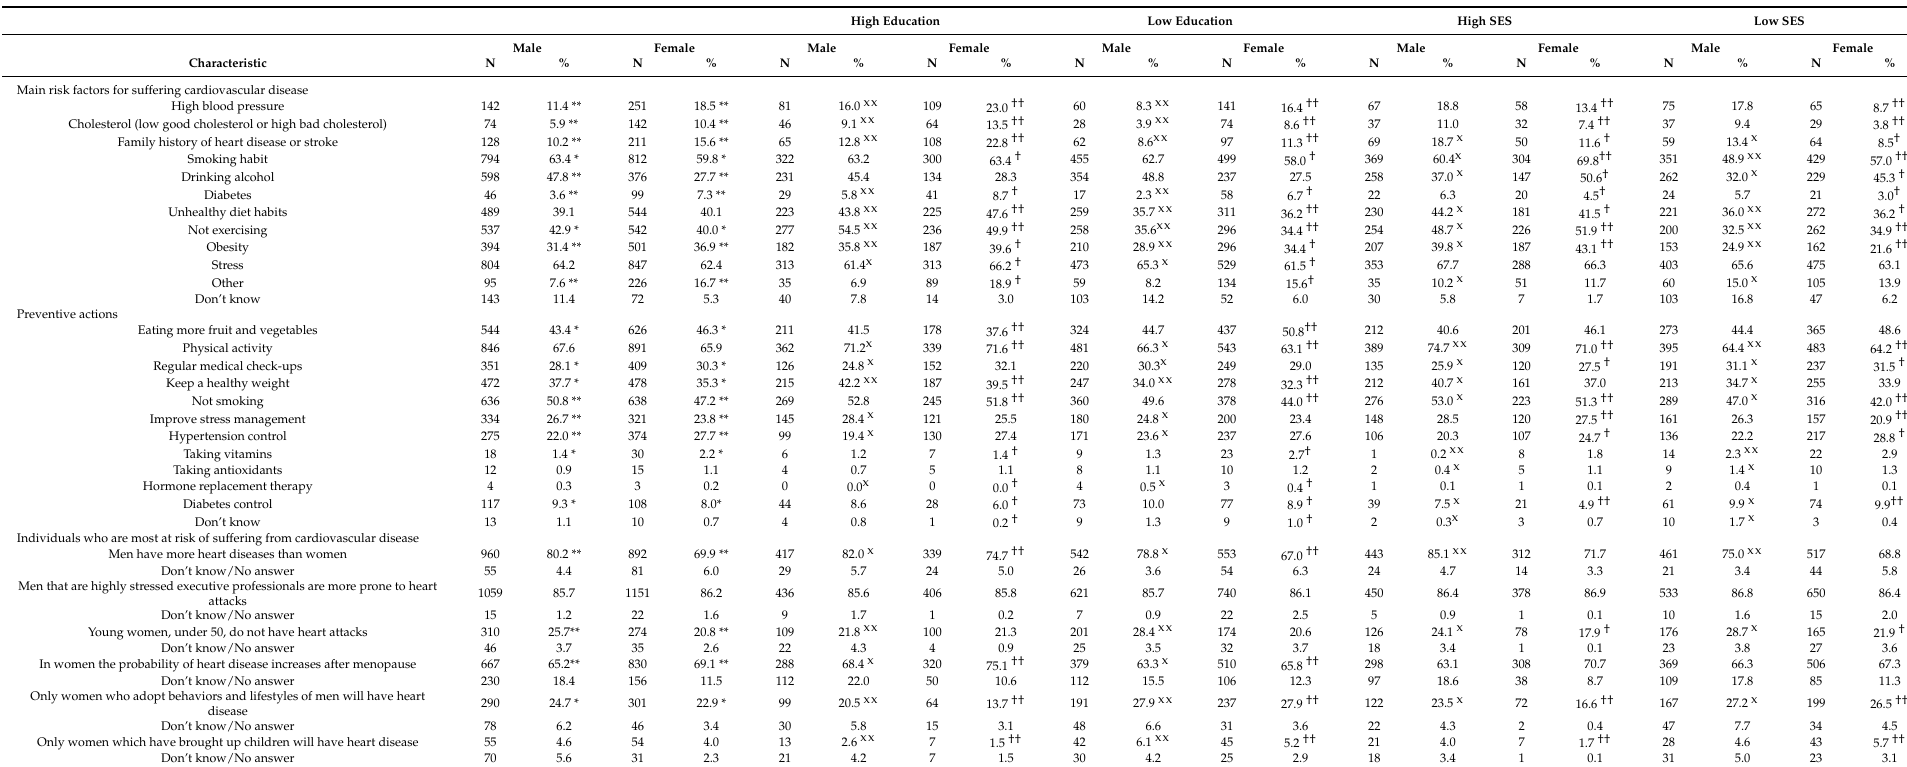
Table 3. Main risk factors, preventive actions and individuals most at risk of cardiovascular disease, according to gender, education and